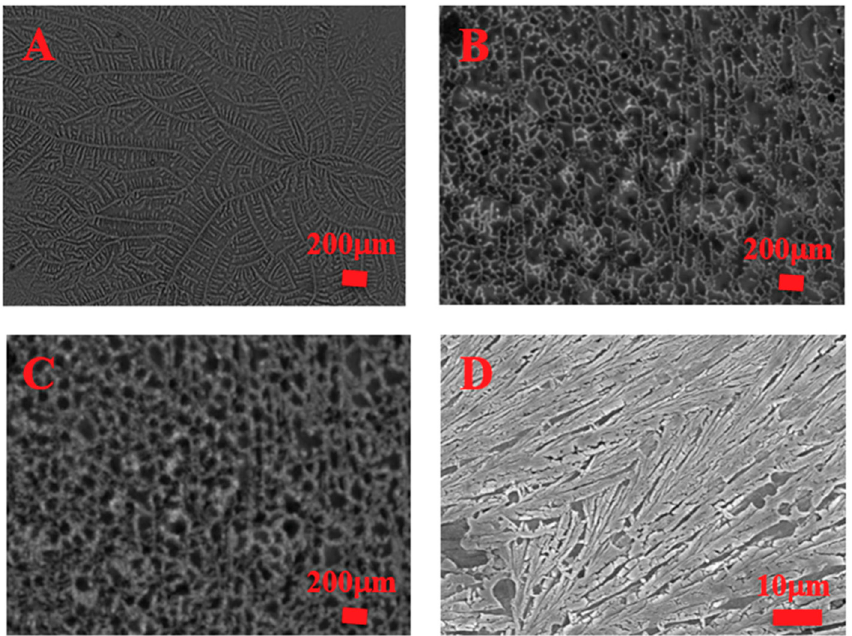
Figure 6. Morphology images of BDTC (Boc- O -dodecyl- L -tyrosine cultured) supramolecular gel in different conditions [6]. ( A ) 4 °C; ( B ) − 20 °C; ( C ) − 80 °C; ( D ) FE-SEM image of the BDTC gel.